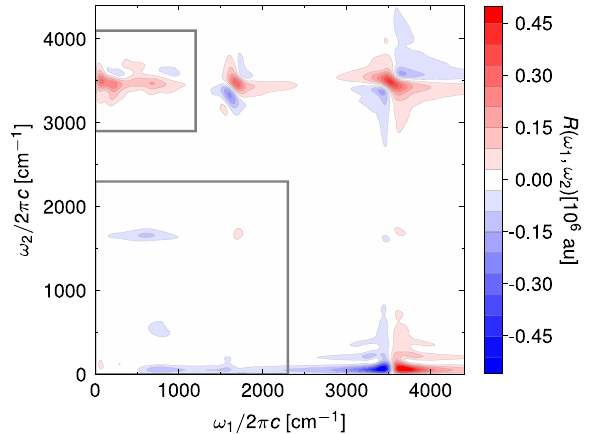
Fig. 2 | Two-dimensional IIR spectrum of liquid water simulated with classical MDat300K. Greysquaresindicatetheregionsof thespectrumthatwestudiedin moredetail,namelytheregionofTIRVspectroscopyandthelow-frequencyregion that covers intermolecular modes and the intramolecular bending mode.